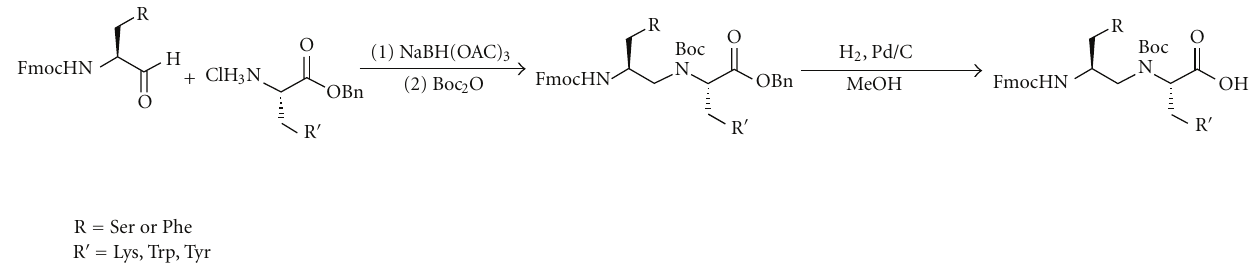
Figure 5: Synthesis of secondary library